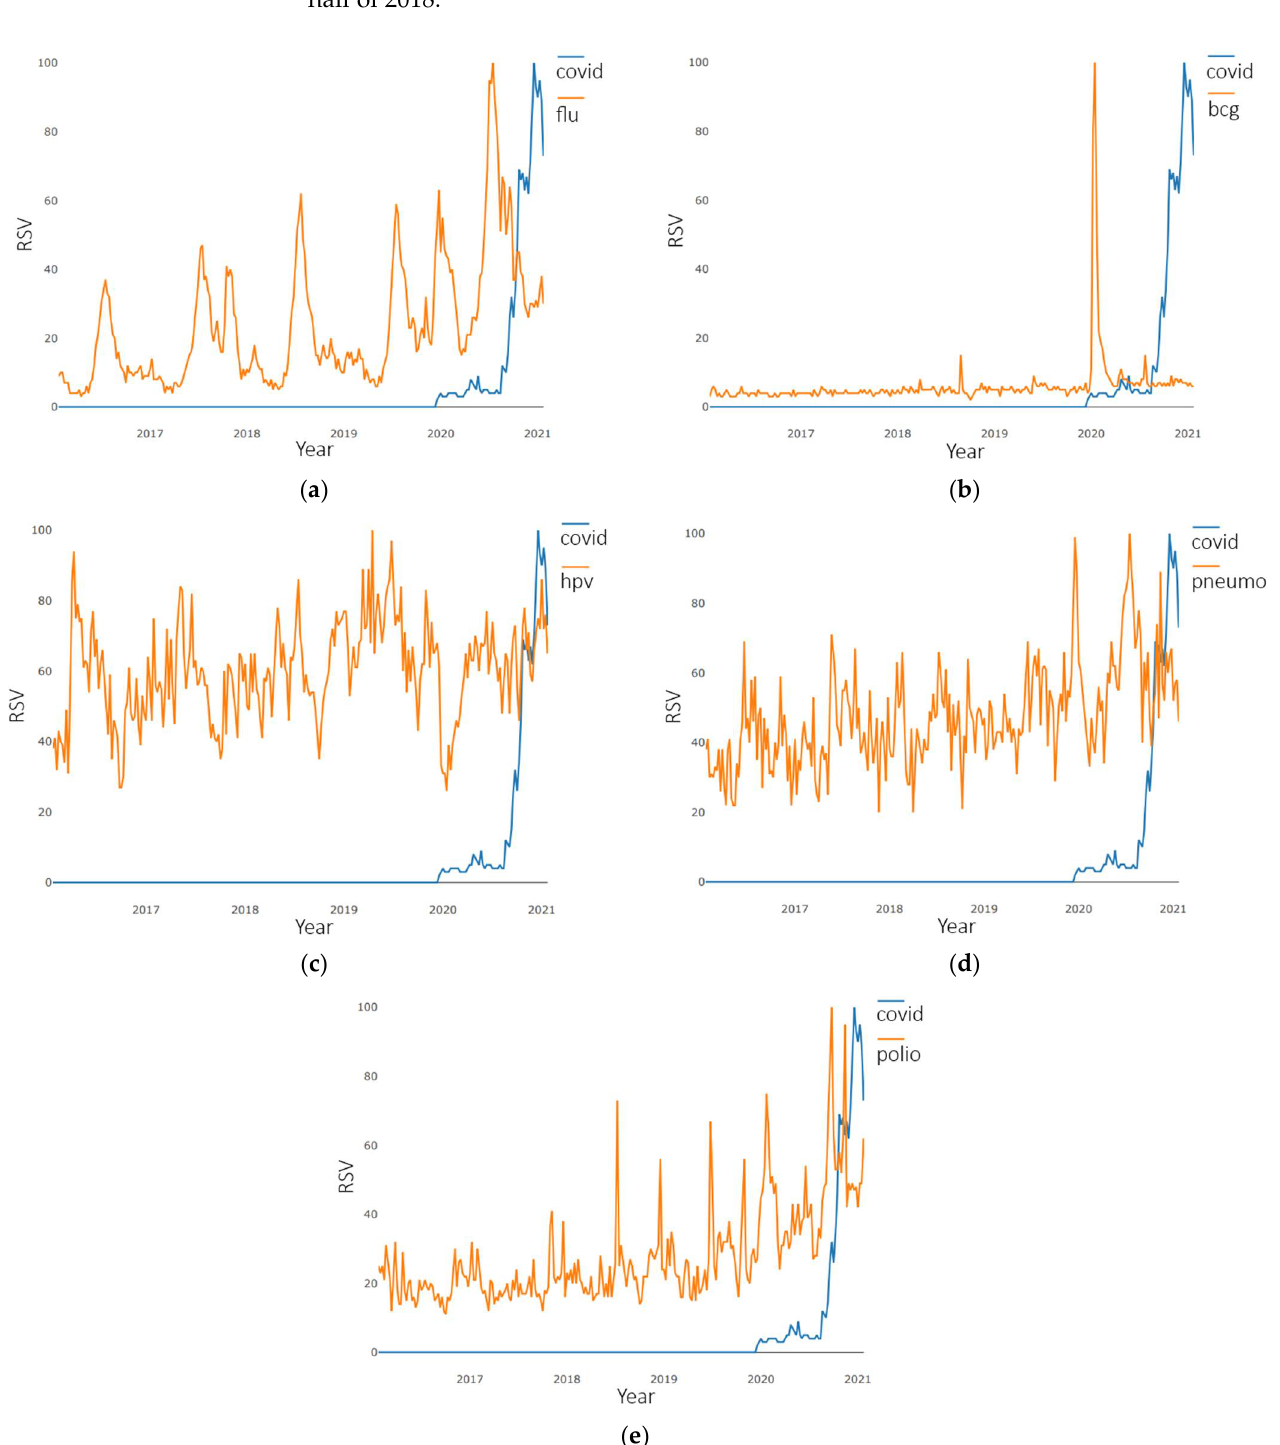
Figure 1. Pairwise time series plots of weekly number of requests (2016–2021) for: ( a ) “covid” and “flu”; ( b ) “covid” and “bcg”; ( c ) “covid” and “hpv”; ( d ) “covid” and “pneumo”; ( e ) “covid” and “polio”. In Figure 1a an increasing trend for both “flu” and “covid” data samples can be no- ticed; with the “flu” time series affected by seasonal factors (with yearly peaks between October and December), cycles were not detected. Figure 1b shows a pronounced trend only for the “covid” sample, while the “bcg” trend stays practically unchanged with no seasonality with only a single major cycle at the end of March 2020. In Figure 1c, a pro- nounced trend can be seen only for the “covid” sample, while the “hpv” trend remains